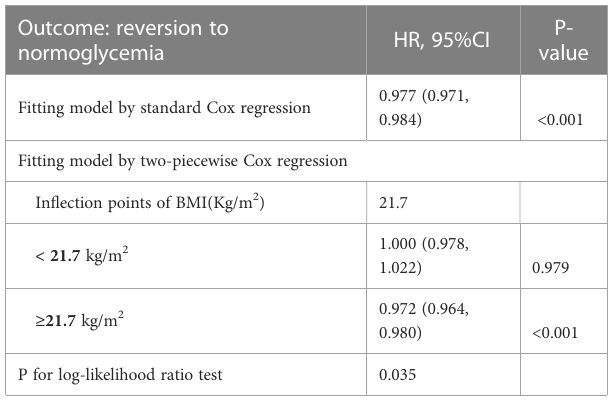
TABLE 7 The result of two-piecewise linear regression model.